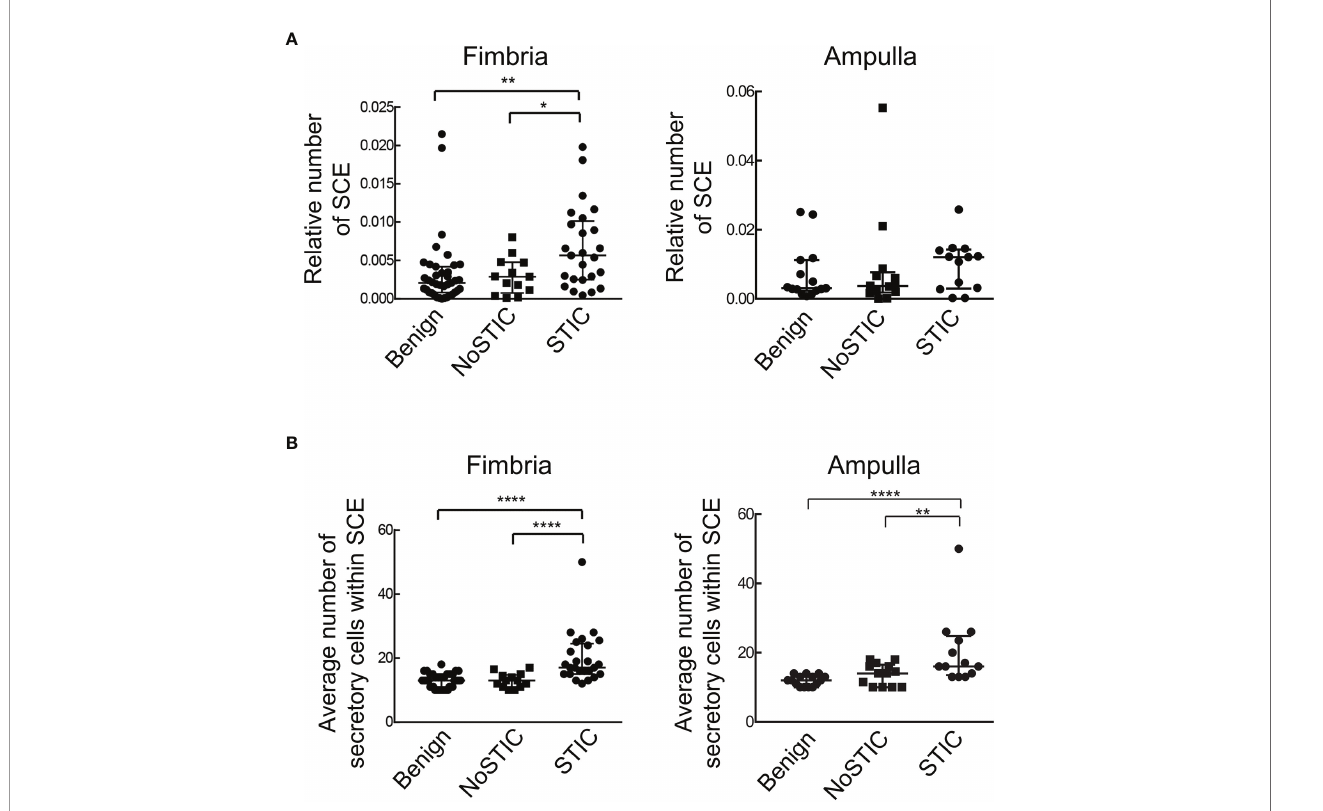
FIGURE 3 | Fallopian tubes with STIC lesions exhibit a higher relative number of SCE as well as a higher number of secretory cells within SCE. (A) The relative number of SCE (number of SCE divided by the total number of epithelial cells in all ROIs on the slide). (B) The average number of secretory cells within SCE. Statistically signi fi cant differences were determined using the Kruskal-Wallis test; * P < 0.05; ** P < 0.01; **** P < 0.0001. Benign: fallopian tubes from women with benign gynecologicconditions. NoSTIC: fallopian tubes without STIC lesionsfrom women with HGSOC. STIC: fallopian tubes with STIC lesionsfrom women with